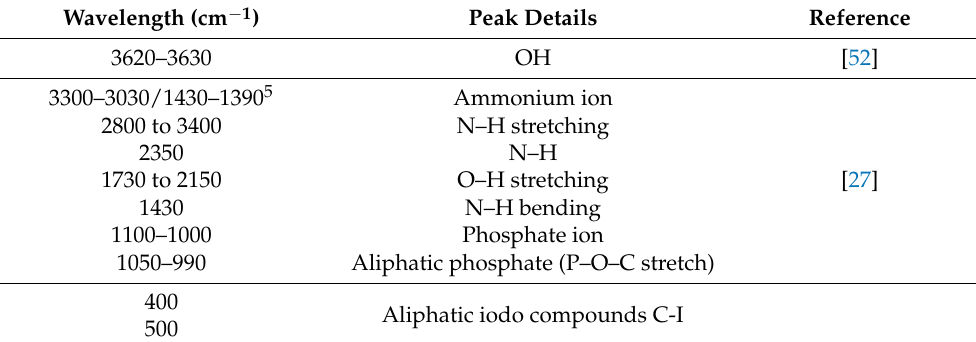
Table 5. Summary of important FTIR transmittance peaks in fire retardant (T2)-treated jute fibers.